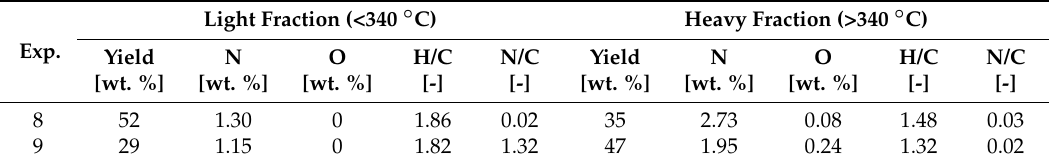
Table 7. Yields (%) and elemental analysis (N and O content in wt. %), H/C and N/C molar ratios of below and above diesel range fraction